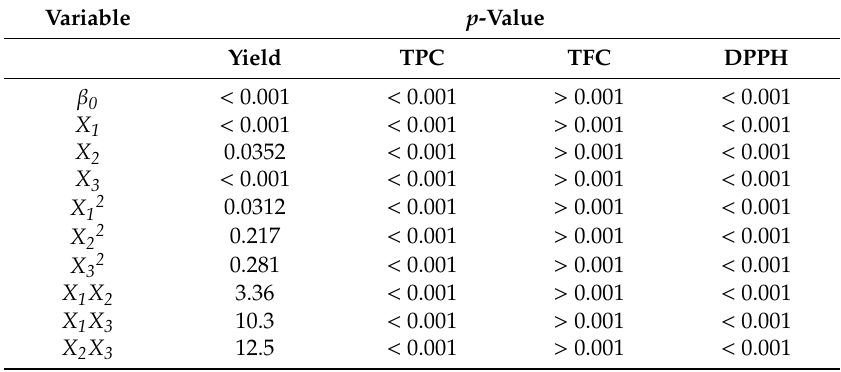
Table 2. Estimated regression model of the relationships among response variables (yield, TPC, TFC, and DPPH of H. erinaceus extracts) and independent variables ( X 1 , X 2 , X 3 ). Variable p -Value Yield TPC TFC DPPH β < 0.001 < 0.001 > 0.001 < 0.001 0 X 1 < 0.001 < 0.001 > 0.001 < 0.001 X 2 0.0352 < 0.001 > 0.001 < 0.001 X 3 < 0.001 < 0.001 > 0.001 < 0.001 X 12 0.0312 < 0.001 > 0.001 < 0.001 X 22 0.217 < 0.001 > 0.001 < 0.001 X 32 0.281 < 0.001 > 0.001 < 0.001 X 1 X 2 3.36 < 0.001 > 0.001 < 0.001 X 1 X 3 10.3 < 0.001 > 0.001 < 0.001 X 2 X 3 12.5 < 0.001 > 0.001 <